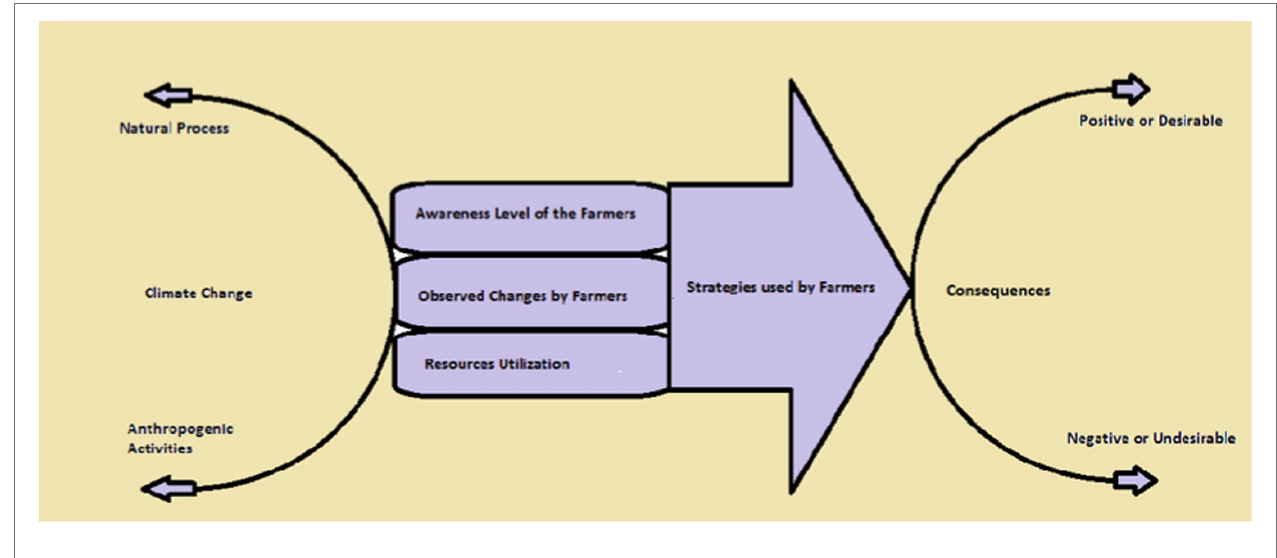
FIGURE 1 | Conceptual framework of the